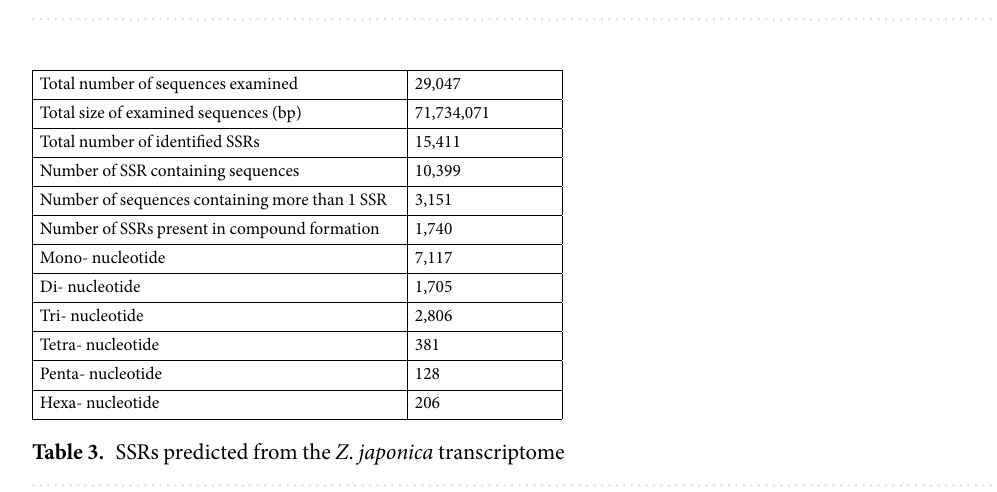
Table 2. ICE clustering analysis. Size: insert fragment size of cDNA libraries; Number of consensus isoforms: the number of consensus isoforms obtained from ICE clustering analysis. Average consensus isoforms read length: sequence length of the consensus isoform; Number of polished high-quality isoforms: the number of high-quality transcripts; Number of polished low-quality isoforms: the number of low-quality transcripts; Percent of polished high-quality isoforms (%): percentage of high-quality transcripts in consensus isoform.